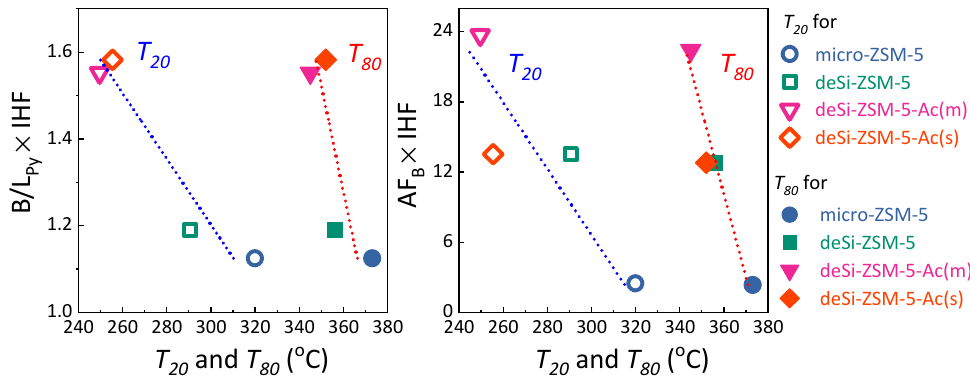
Figure 4. ( left ) B / L Py × IHF and ( right ) AF B × IHF coupled factors (B / L Py —ratio of B.a.s. to L.a.s; IHF—indexed hierarchy factor; AF B —accessibility factor of B.a.s.) plotted against the temperatures for 20% and 80% conversion ( T 20 and T 80 ) for LDPE cracking.